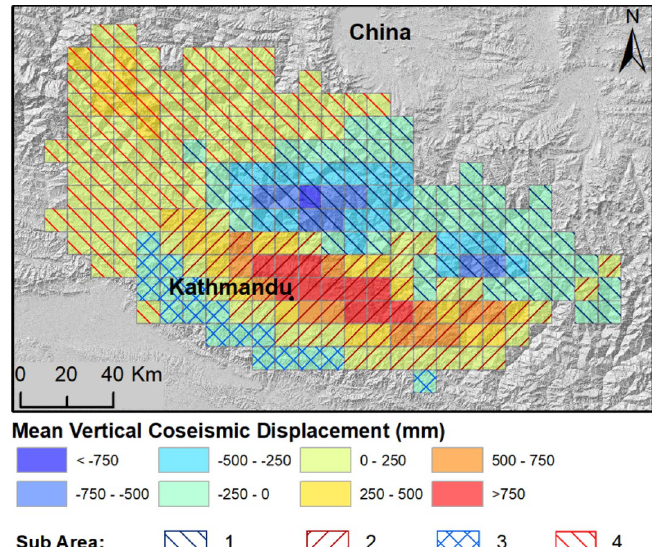
Figure 5. Mean vertical coseismic displacement (VCD, mm) computed in each 10 × 10 km cell of the study area from ALOS-2 InSAR data (Supplementary Figure S4). Negative and positive values indicate ground subsidence and uplift, respectively. Black lines indicate the districts in Nepal. The four sub-areas (1, 2, 3 and 4), identified according to the displacement values, are shown. The vertical coseismic displacement is derived from the LOS displacement developed by Lindsey et al. 19 . (The map was generated by using ArcGIS 10.3.1, http://www.esri.